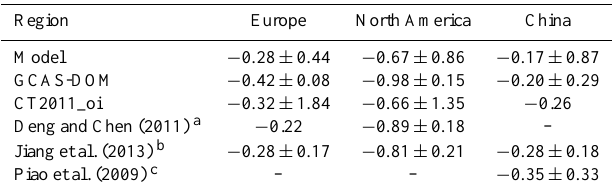
Table 4. Comparison of the long-term mean optimized carbon fluxes by GCAS-DOM with previous studies during 2001–2007. Region Europe North America